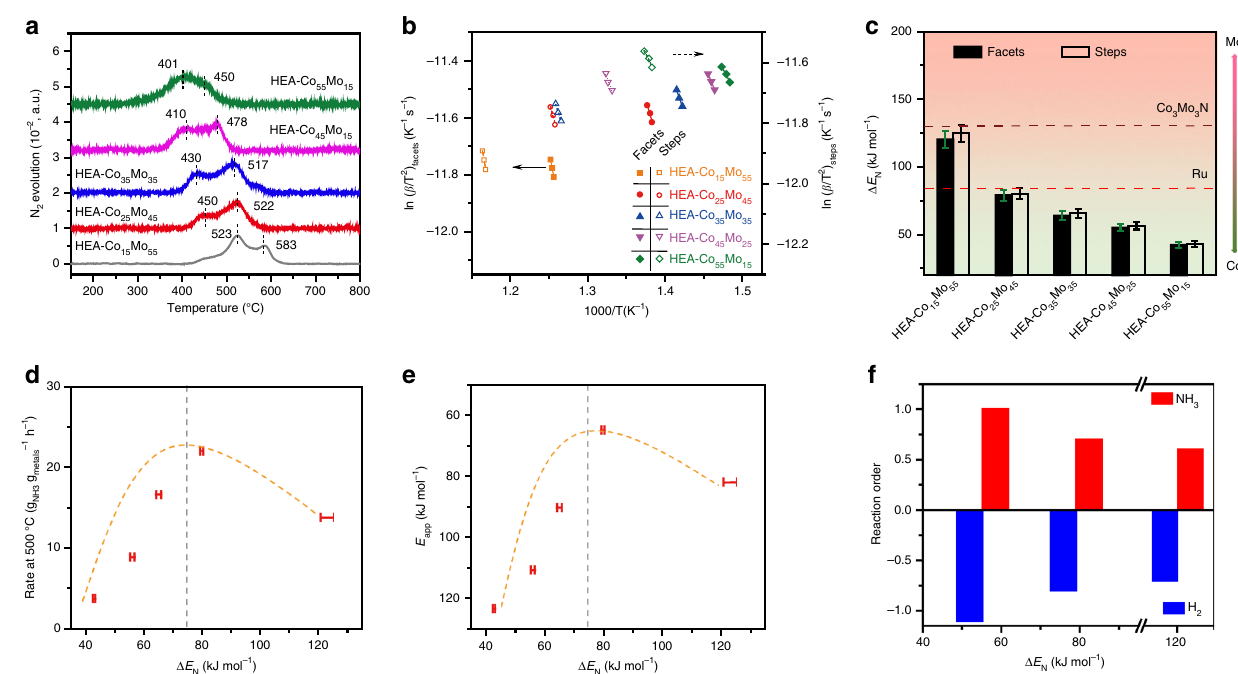
Fig. 5 Surface adsorption properties of HEA-Co x Mo y . a Nitrogen TPD pro fi les recorded with a temperature ramping rate of 10 o C min − 1 . b , c Estimation of the nitrogen adsorption energies ( Δ E N ) for the HEA-Co x Mo y catalysts by using the plots of Ln( β / T 2 ) ~ 1/ T for the nitrogen TPD pro fi les ( β = 10, 20, and 30 o C min − 1 represents the ramping rates used for the TPD measurements). d , e Correlations between Δ E N and catalytic activities ( d ) and E app ( e ) showing a volcano-type behavior for the HEA-Co x Mo y catalysts, with HEA-Co 25 Mo 45 being close to the peak position. f Plots of the NH 3 and H 2 reaction orders (at 425 o C) versus the nitrogen adsorption energies. Error bars denote peak, the catalysts (more Co-rich) bind to N too weakly and thus gives rise to rather higher kinetic barriers for dehydrogenation (NH 3 → *NH 2 → *NH → *N), whereas on the right side (more Mo-rich) the binding is too strong for N to recombine and desorb from the surface (2*N → N 2 ), and a tradeoff between these two factors gives rise to an optimal, intermediate binding energy for